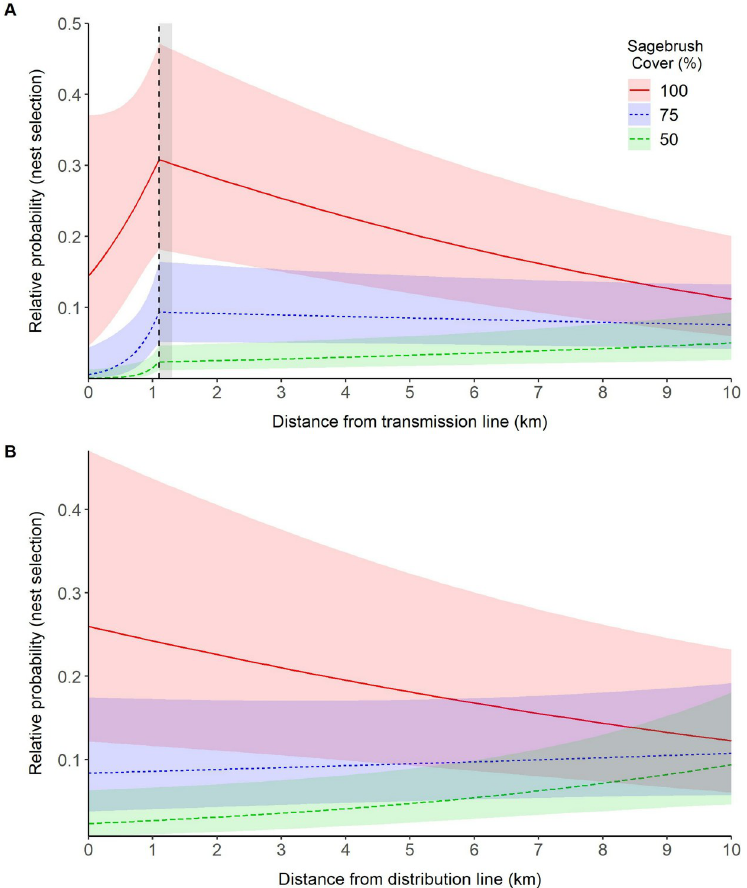
Fig 3. Effect of power lines on the relative probability of nest site selection of greater sage-grouse ( Centrocercus urophasianus ; sage-grouse) throughout Utah, portions of southeastern Idaho, and southwestern Wyoming, USA, 1998–2013. Lines are population-averaged fitted values from the best-fit GLMM (S3 Appendix) describing the effects of transmission lines (A) and distribution lines (B) on sage-grouse nest site selection. The vertical dashed line identifies the response threshold at which sage grouse response changes. The shaded areas highlight uncertainty ( Δ AICc < 2) around the location of the response